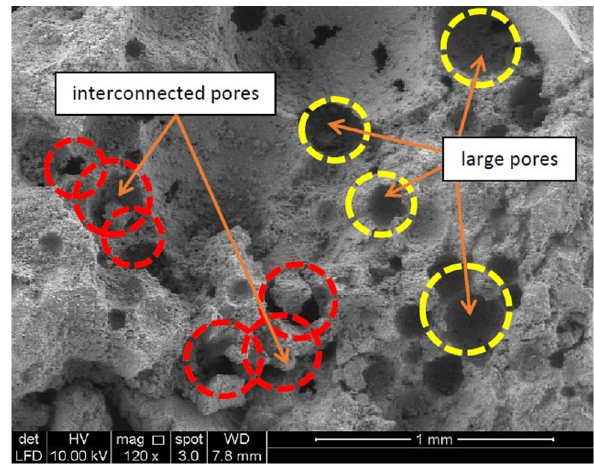
Figure 21. Relationship between water absorption and porosity.